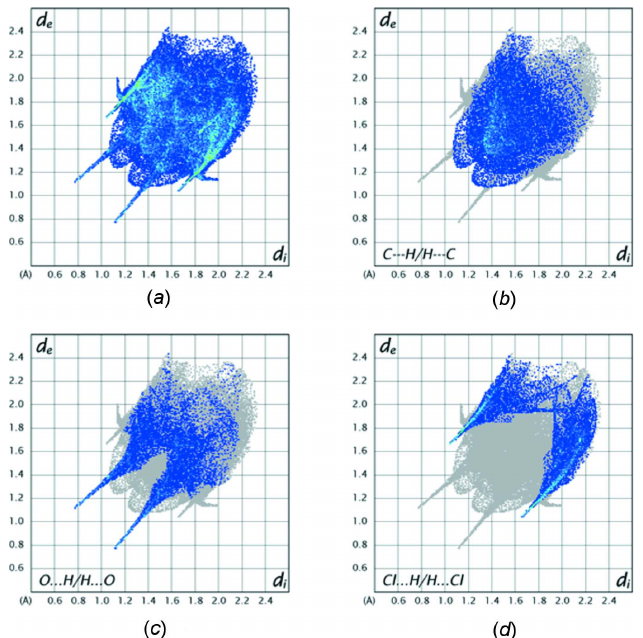
Figure 6 Fingerprint plots for the title molecule: ( a ), all intermolecular inter- actions; ( b ), C (cid:2)(cid:2)(cid:2) H/H (cid:2)(cid:2)(cid:2) C interactions; ( c ), O (cid:2)(cid:2)(cid:2) H/H (cid:2)(cid:2)(cid:2) O interactions; ( d ), Cl (cid:2)(cid:2)(cid:2) H/H (cid:2)(cid:2)(cid:2) Cl interactions.